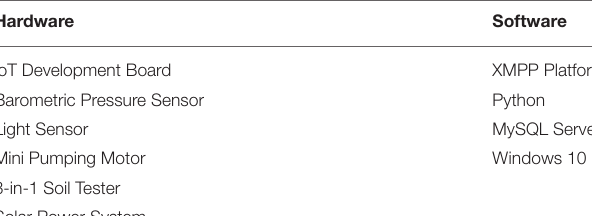
TABLE 1 | The software and hardware the proposed